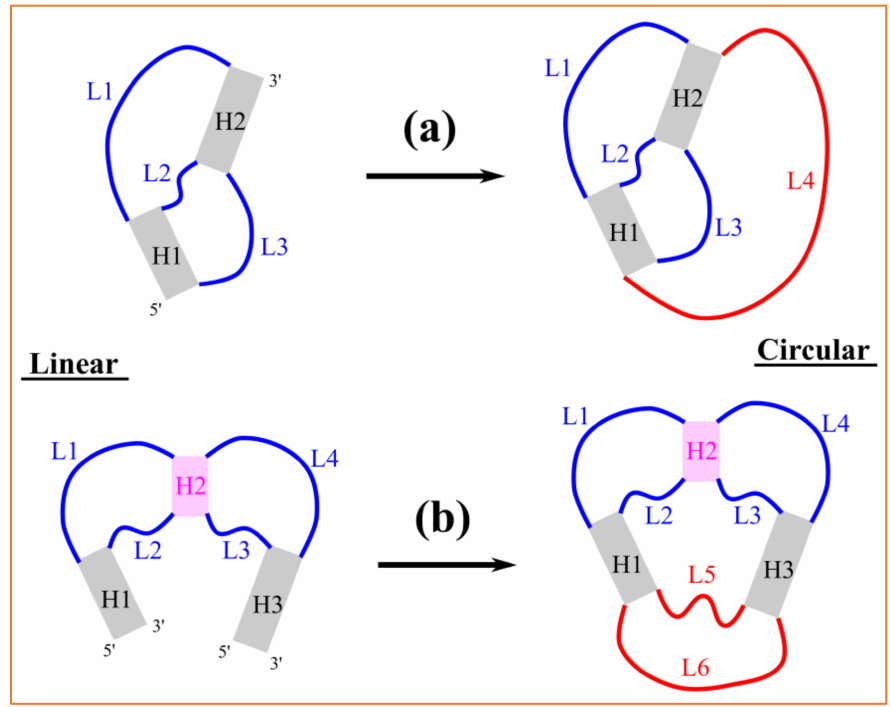
Figure 4. Extension of the H-PK and L-KISS motifs. ( a ) The H-PK motif of a linear RNA contains two helices and three loops ( left ). ( b ) The L-KISS motif of two linear RNAs contains three helices (H2 is the kissing helix) and four loops ( left ). For circular RNAs ( right ), the H-PK and L-KISS motifs need to be extended with the additional loops (marked in